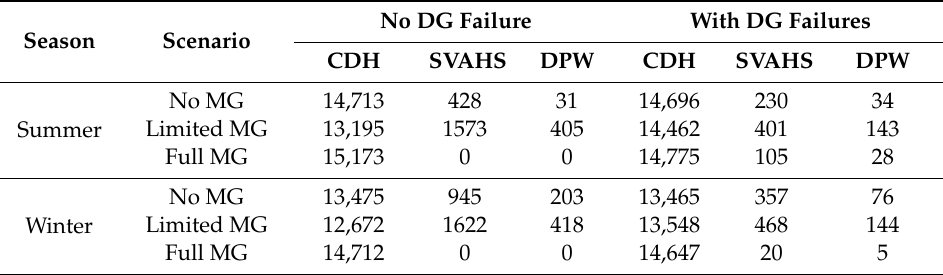
Table 12. Mean diesel fuel consumption (gallons) of the system with CDH PV in 14 days